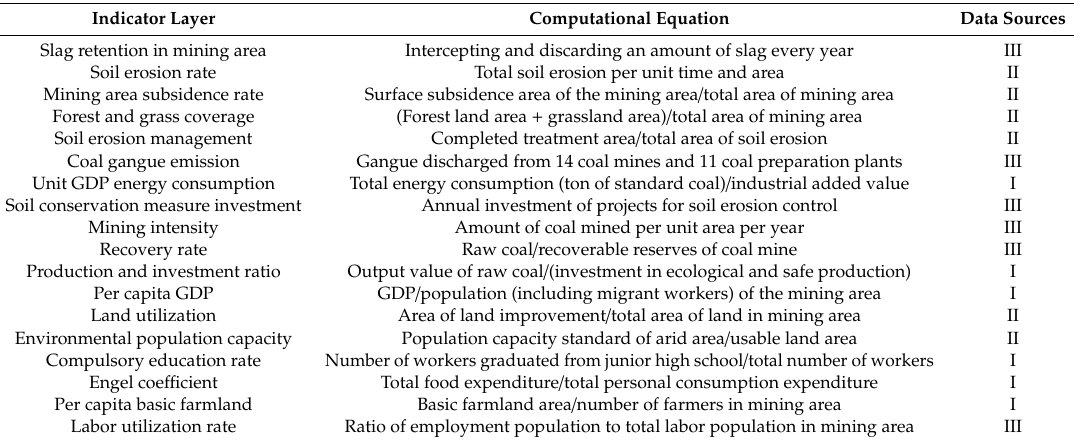
Table 1. Evaluation index system of soil and water conservation